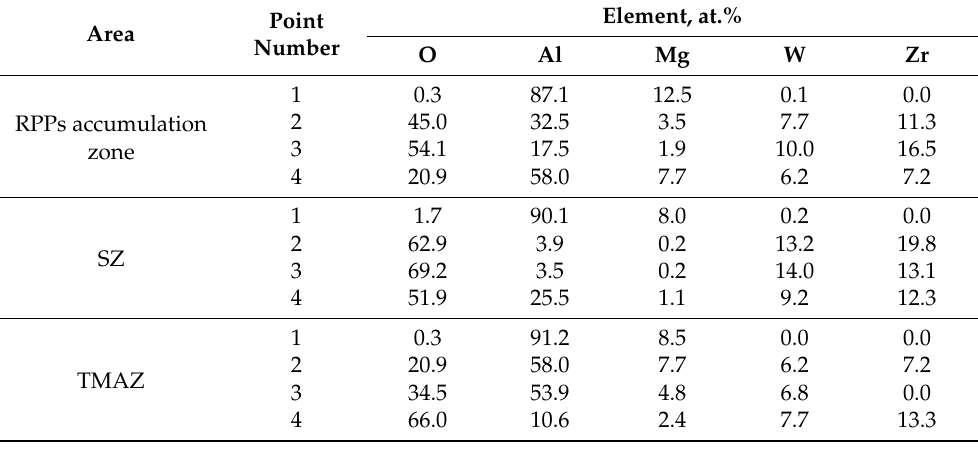
Table 2. Chemical composition (EDS) of an etched section of FSP-ed RPPs/AA 5056 after 8 tool